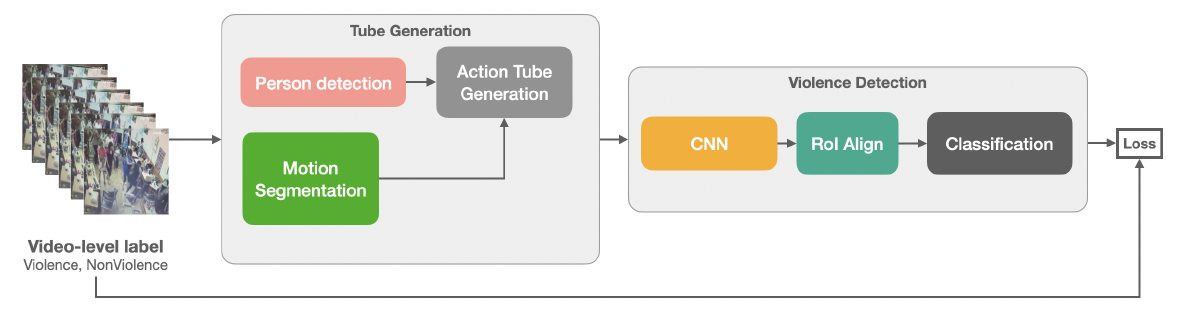
Figure 1. Overview of the proposed